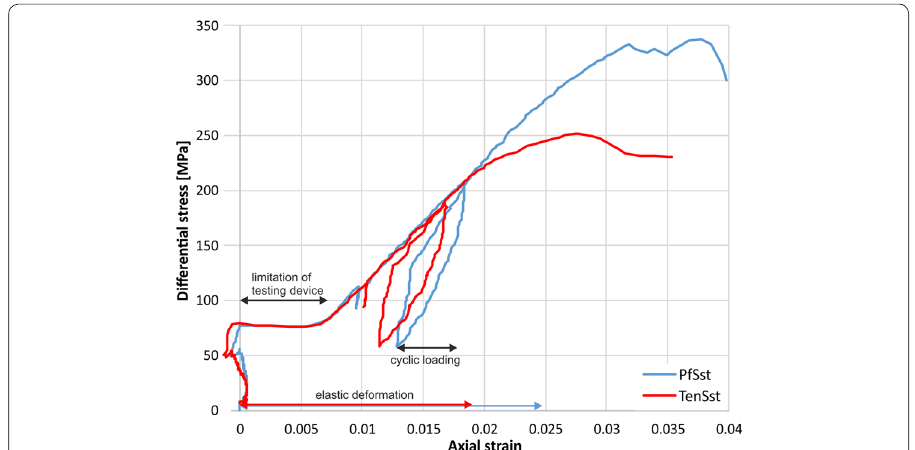
Fig. 4 Exemplary differential stress–strain curves for PfSst and TenSst with a confining pressure of 50 MPa, showing the deformation of the two samples. The non-linear behavior for low stresses (strain up to ~ 0.007) is related to limitations of the testing device and the application of the confining pressure